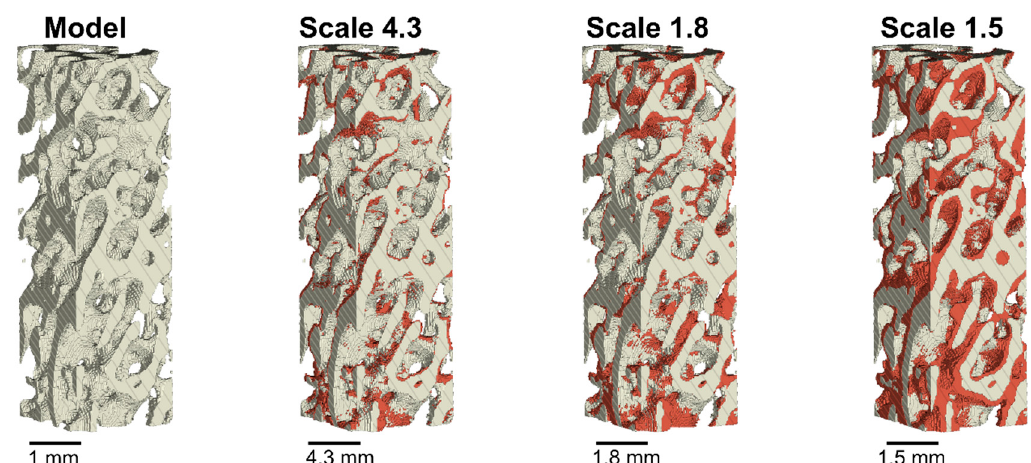
Figure 5. Volumetric comparison of the original bone model and the overfilling volumes from the printed samples at the different scales. The original model is displayed in grey, and the overfilled material in red. Note, the model has been scaled up to the scale of the printed parts in these comparisons. Table 8. Quantification of underfilling and overfilling for printed models of different scales (1.5, 1.8 and 4.3).